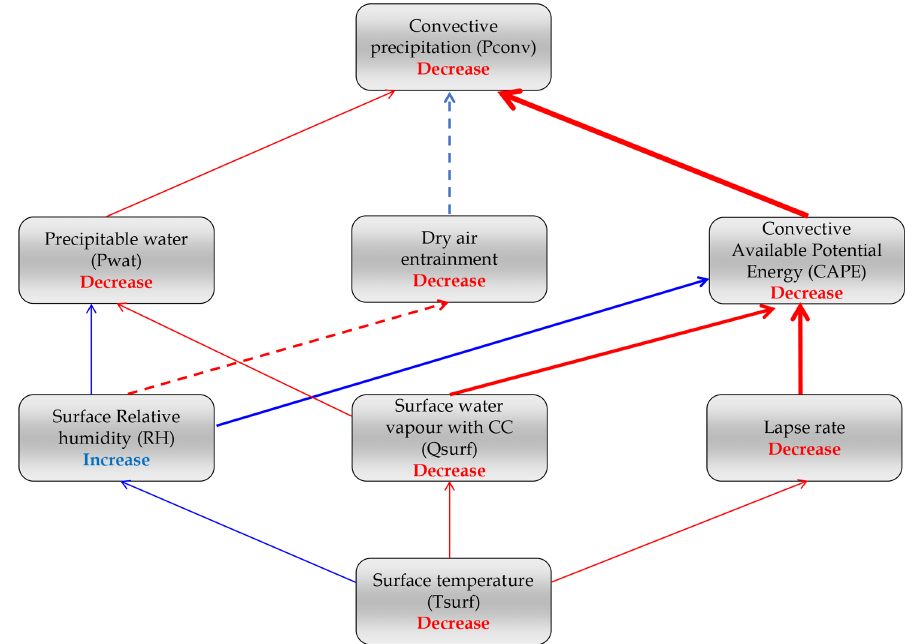
Figure 14. Detailed schematic summary of the causal sequence that links the decrease in surface temperature to the decrease in convective precipitation in our polluted simulation. The size of the arrows gives a qualitative estimation of the contributions of each process. Dashed arrows indicate uncertain